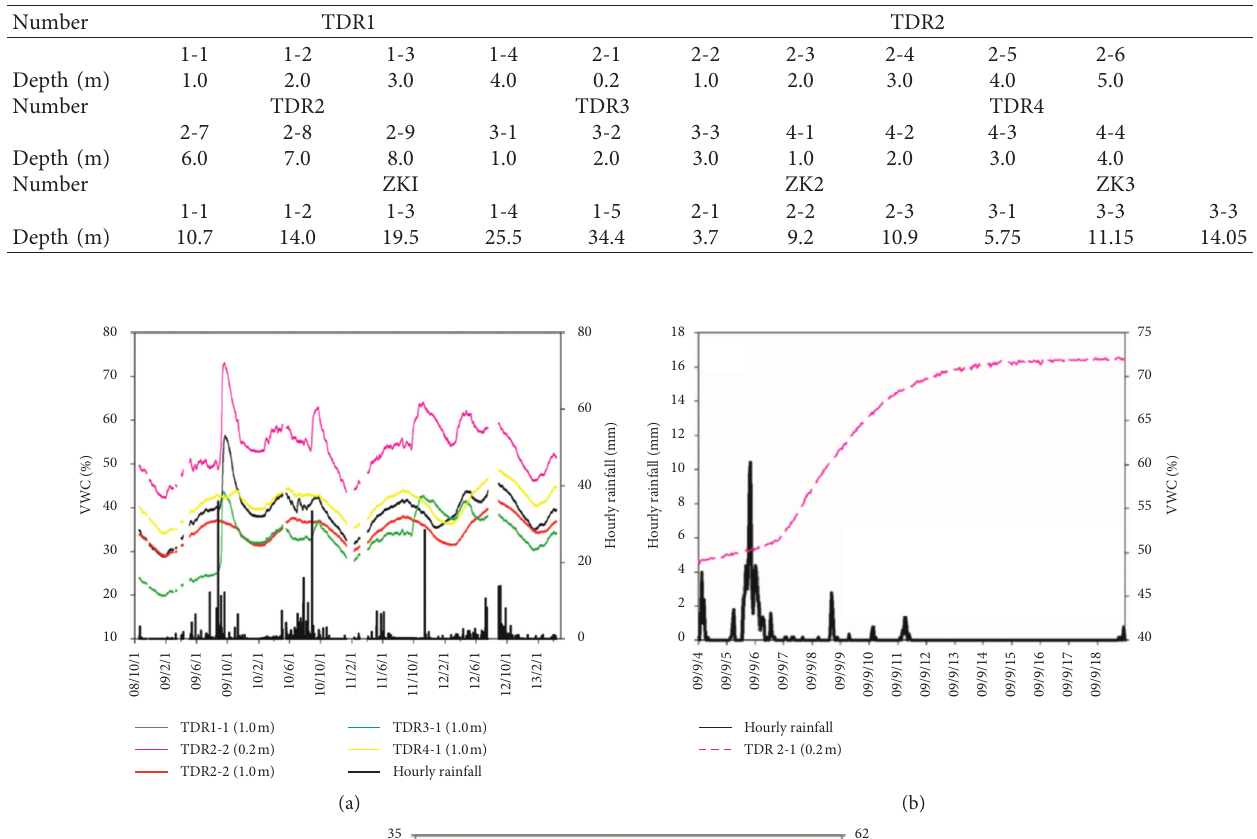
Table 2: Distribution of TDR (landslide No. 2) and ZK (landslide No. 1) monitoring system.